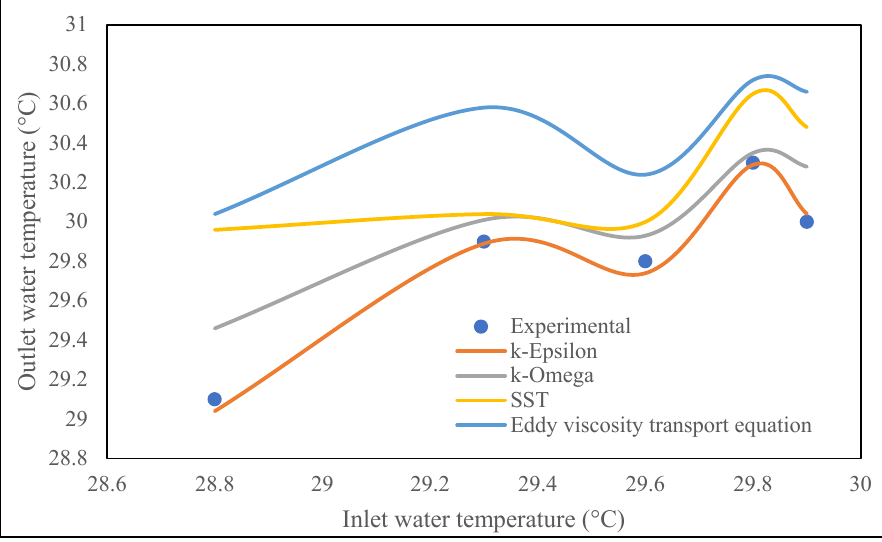
Figure 6. Validation of various models.